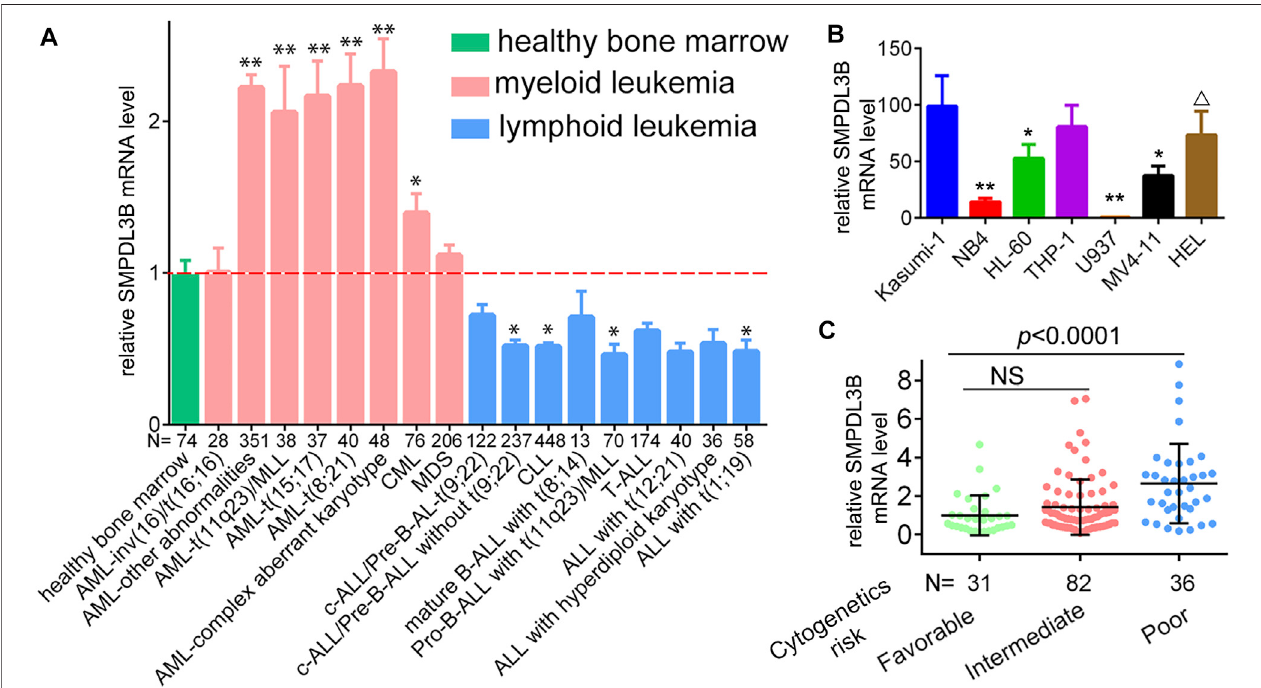
FIGURE 1 | SMPDL3B is highly expressed in AML patients and cell lines. (A) Relative mRNA expression of SMPDL3B in different karyotypes of AML vs. healthy samples. * p < 0.005, ** p < 0.001 compared to healthy control. (Data were obtained from GSE13159.) (B) qRT-PCR analysis of SMPDL3B mRNA expression in the indicated cell lines. All the levels of SMPDL3B mRNA expression were normalized by GAPDH. (C) Relative SMPDL3B mRNA expression in human AML patients with indicated cytogenetics risk. The data were obtained from the TCGA AML database.